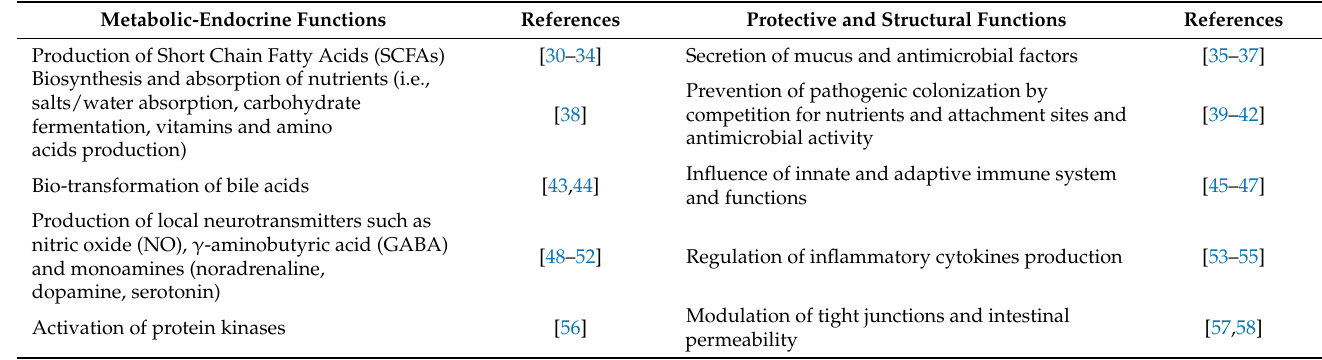
Table 1. Health-related functions of gut